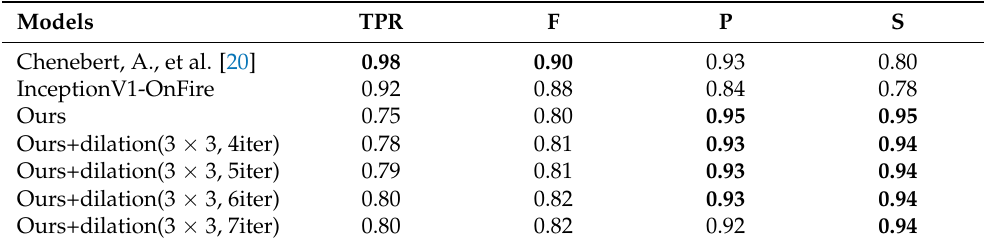
Table 2. This table presents the quantitative results of the proposed method on the furg fire dataset [15], in comparison with prior works for the in-frame fire localization problem. The bolded values highlight each metric’s top